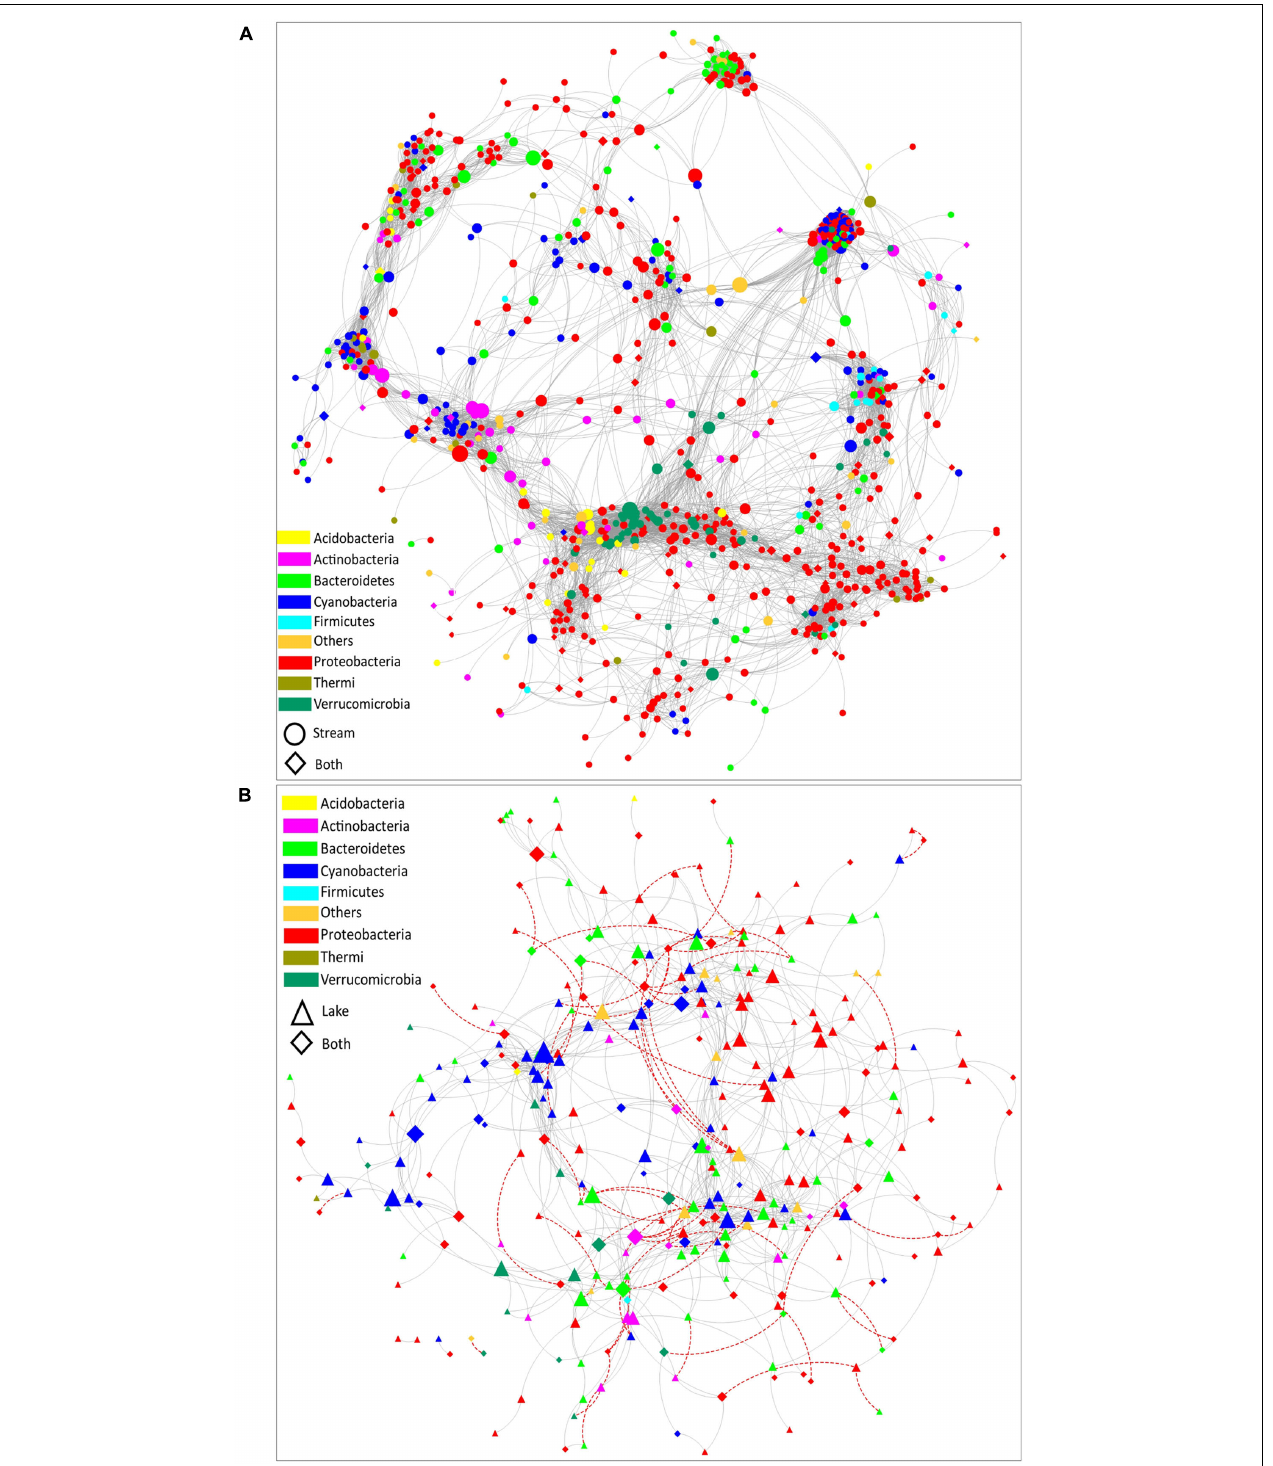
FIGURE 5 | The co-occurrence network of bacterial communities in (A) stream biofilms and (B) lake water. Edges represent correlation relationships. Gray solid lines indicate positive associations (co-occurrence interactions) and red dashed lines indicate negative associations (co-exclusion interactions). Only strong and significant relationships (spearman R > 0.7 or R < –0.7, P < 0.01) are shown. Nodes are sized by the OTU betweenness and colored by phylum. Circle nodes represent OTUs with a relative abundance higher than 0.01% only in the stream samples. Triangle nodes represent the OTUs with a relative abundance higher than 0.01% only in the lake samples. Diamond nodes represent the OTUs with a relative abundance greater than 0.01% in both lake and stream samples.